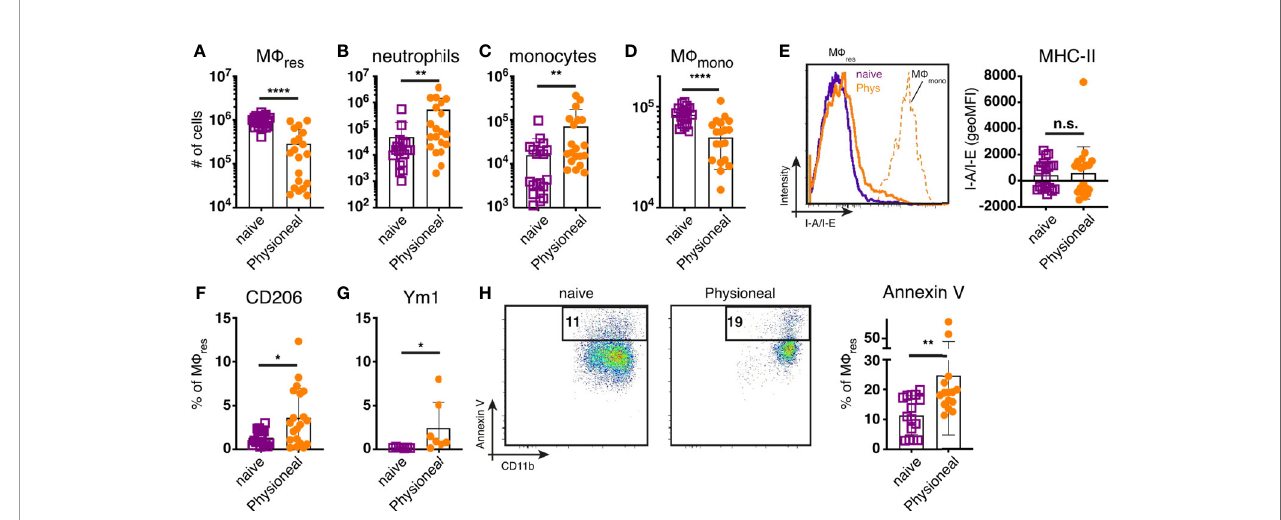
FIGURE 1 | Injection of dialysis fl uid alters peritoneal myeloid cell composition. C57BL/6 mice were injected with Physioneal ( fi lled circles) or left untreated (open squares) and whole PEC isolated 6 h later. Cells were counted and analysed by fl ow cytometry to determine the number of (A) M F res (lineage-CD11b+, F4/80high, MHC-II low), (B) neutrophils (lineage +, SSC mid, MHC-II-,F4/80-,CD11b+), (C) monocytes (lineage-CD11b+, F4/80-,MHC-II low, Ly6C high) and (D) M F mono (lineage-CD11b+, F4/80low,MHC-II high). (E) Histogram and quantitative data of fl uorescence mean intensity of MHC-II expression by M F mono (orange, dashed line) or M F res from Physioneal injected (orange, solid line) or naive animals (purple, solid line). (F – H) Expression of CD206, Ym1 and binding of Annexin V by M F res identi fi ed in (A) assessed by fl ow cytometry. Datapoints depict individual animals and bars indicate mean and SD. Data pooled from 4 independent experiments using 3-5 animals per group. Data analysed using a Mann-Whitney-U test after transformation. n.s., not signi fi cant; *p < 0.05; **p < 0.01; ****p < 0.0001. lineage: TCR b CD19 Siglec-F